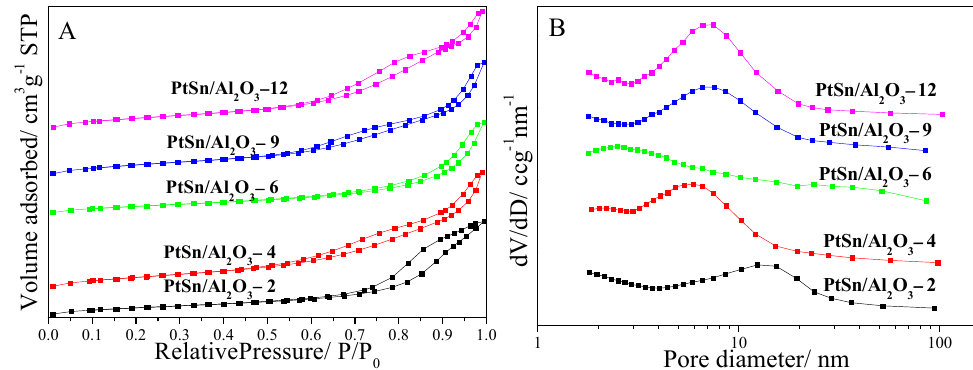
Figure 2. Nitrogen adsorption–desorption isotherms ( A ) and pore distribution ( B ) of PtSn/Al 2 O 3 catalysts. Table 1. Textural properties and Pt dispersions of PtSn/Al 2 O 3 catalysts, I D /I G by Raman characteri- zation of the spent catalysts.